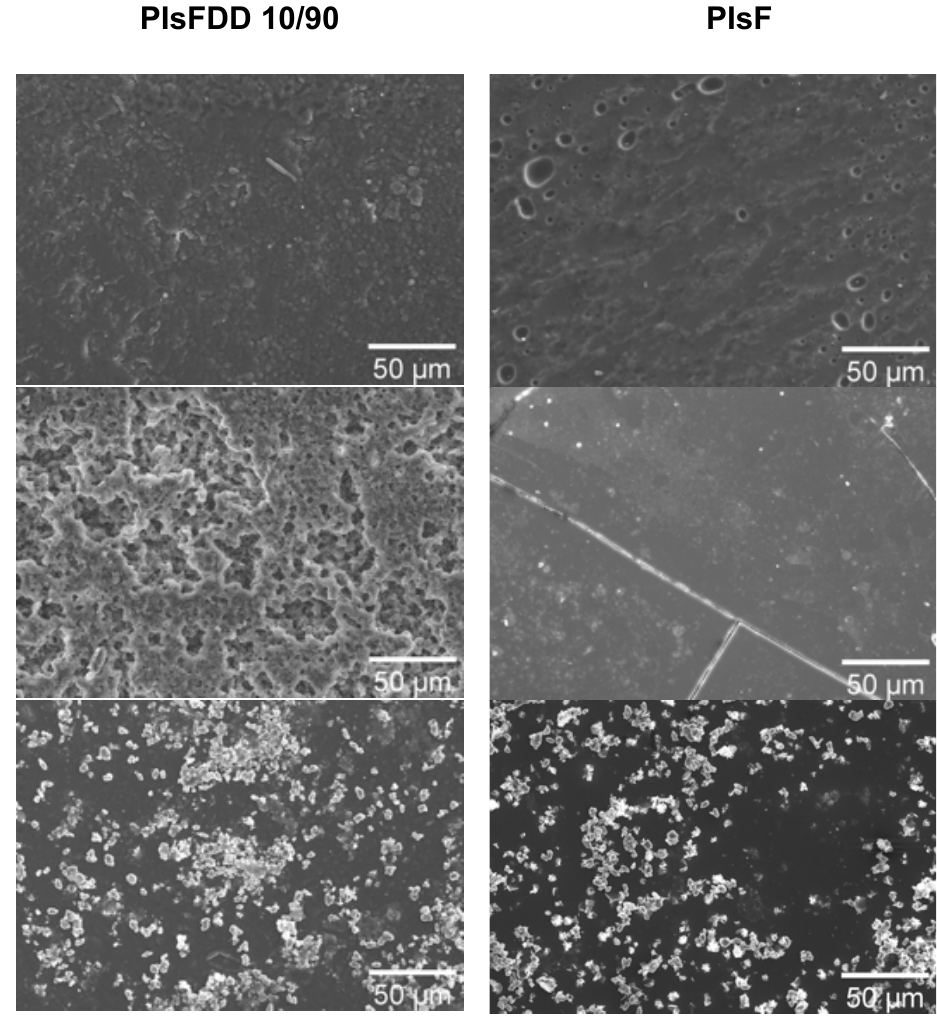
Figure 6. Comparison between typical SEM micrographs of PIsFDD 10/90 and PIsF after 63 days of degradation in PBS, enzymatic, and simulated sea water condition environments (1k times magni- fication).